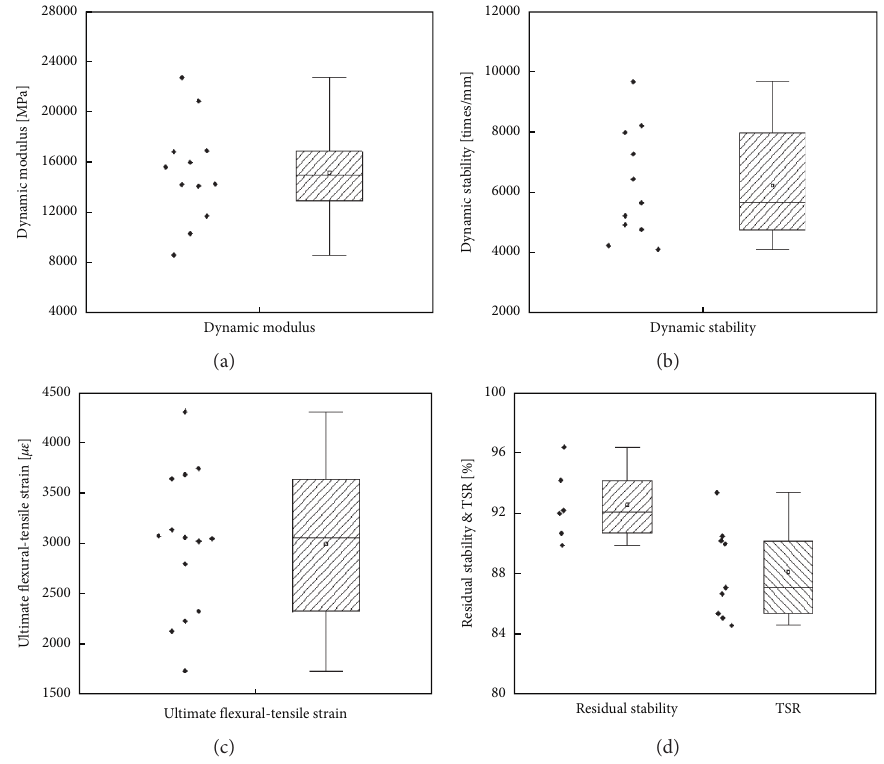
Figure 8: Performance of self-blending high modulus asphalt mixture [28, 30, 32, 36, 39, 42–54]: (a) dynamic modulus; (b) dynamic stability; (c) ultimate flexural-tensile strain; (d) residual stability and TSR.